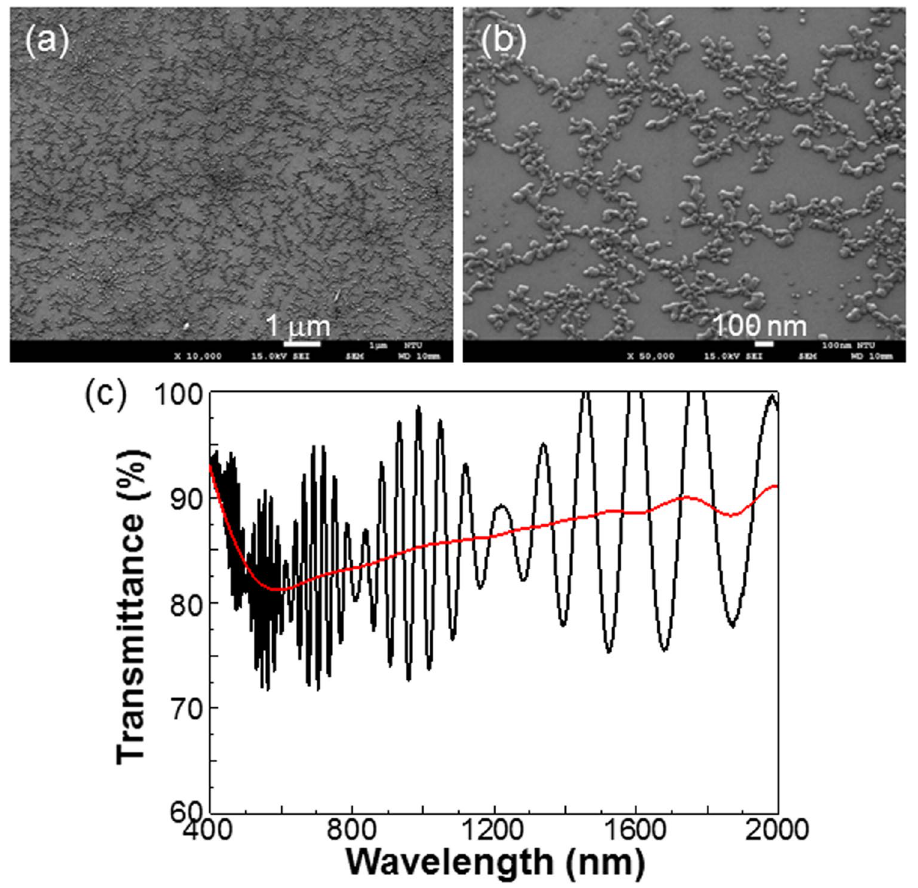
Figure 14. ( a ) SEM image of an Ag nano-network structure. ( b ) Magnified SEM image of the Ag nano-network structure. ( c ) Transmission spectra of this Ag network structure, including the oscillating measured data (black) and smooth fitted result